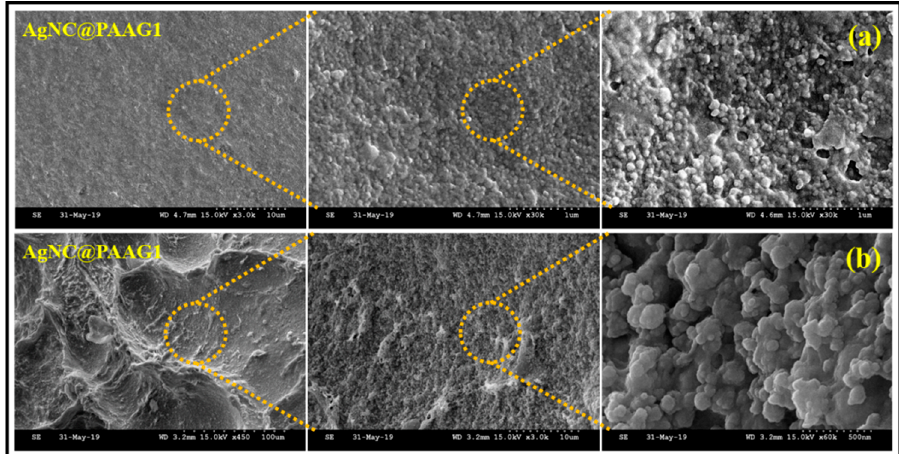
Figure 6. SEM morphology of guar gum based silver nanocomposite hydrogels ( a ) surface view of AgNC@PAAG1 ( b ) cross-sectional view of AgNC@PAAG1. (Scale = 100 µm, 10 µm and 500 nm, respectively, from left to right). Adopted from [155], with permission from Elsevier, 2020.